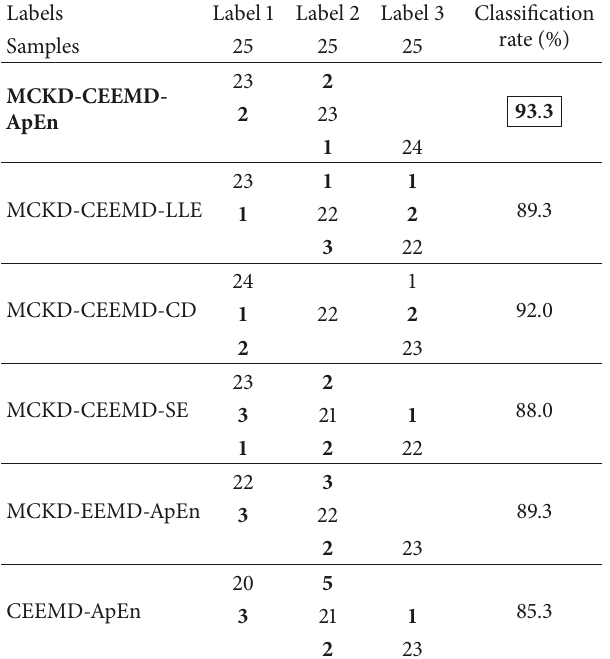
Table 5: Classification